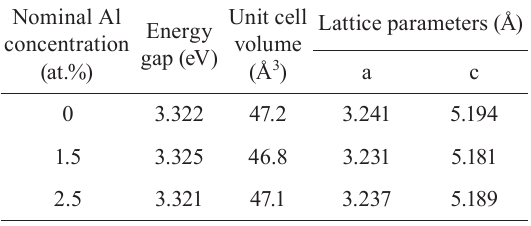
Table 3 Lattice parameters, unit cell volume and